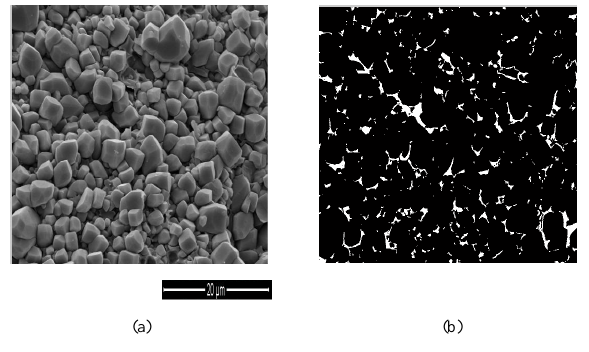
Figure 5. Image segmentation of sample S 1 : a) Original SEM image, b) Binary image result 11 (white pixels for pores and black for grains). 12 Fig. 5. Image segmentation of sample S 1 : (a) Original SEM image, (b) Binary image result (white pixels for pores and black for